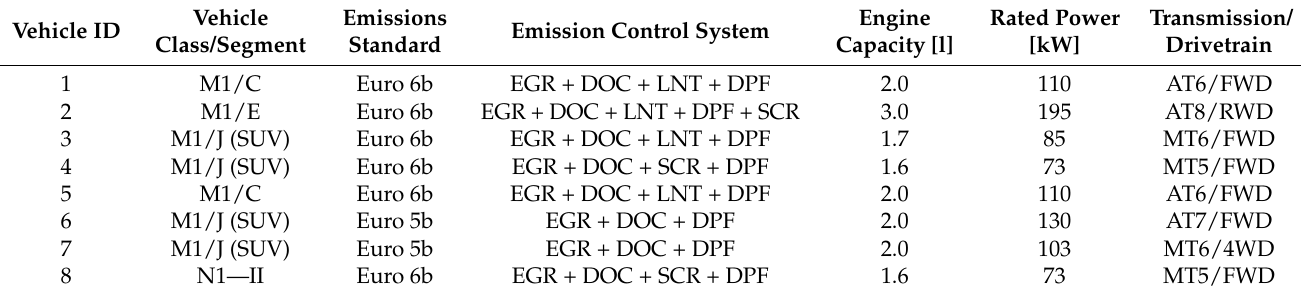
Table 1. Specifications of the tested vehicles